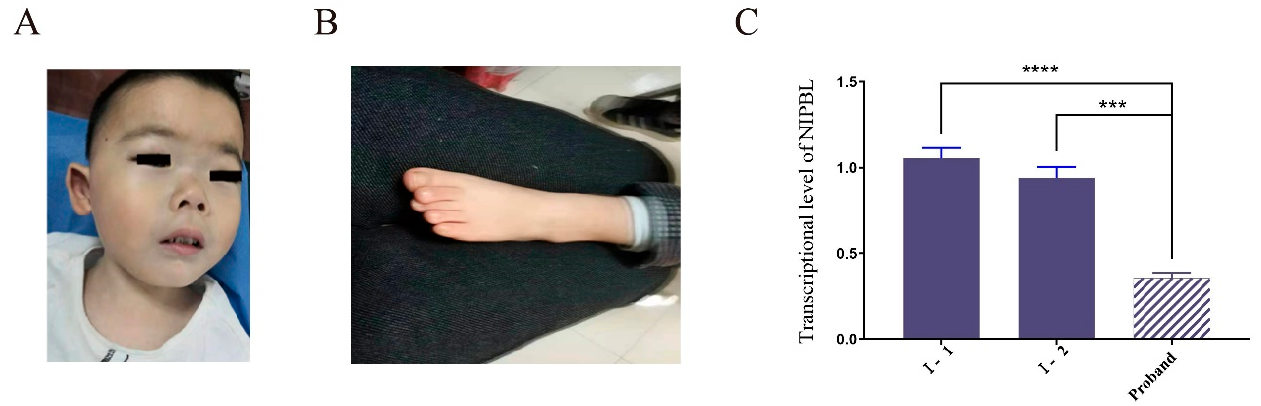
Figure 1. Clinical features. ( A ) The patient had well-defined and arched eyebrows with synophrys; narrow palpebral fissures; long and curly eyelashes; broad nose with high nasal bridge; and broad mouth. ( B ) The short left fifth toe was observed in the boy. ( C ) Quantitative analysis of NIPBL expression in patient and his parents. *** p ≤ 0.001, **** p ≤